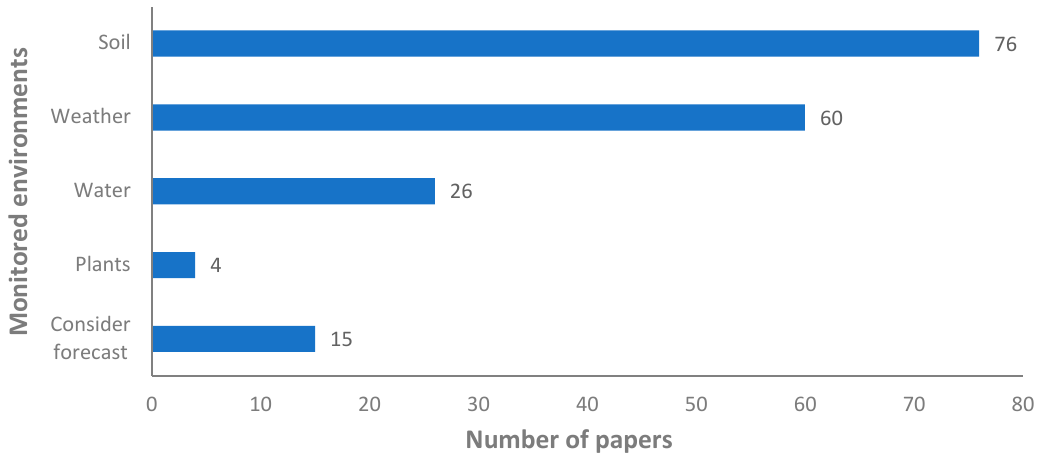
Figure 5. Monitored environments in papers that propose an irrigation system.